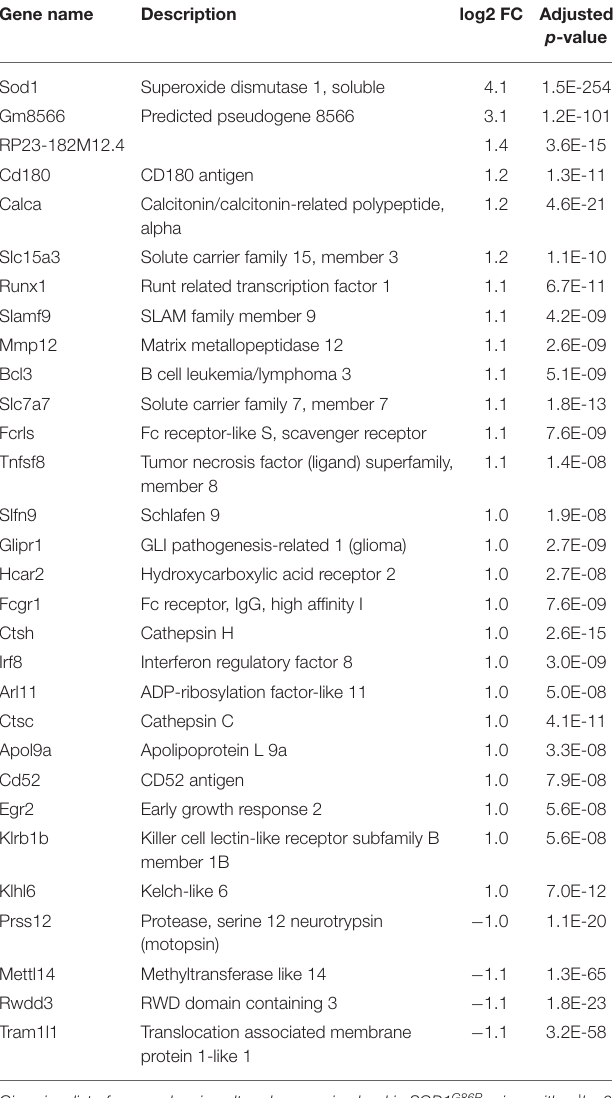
TABLE 1 | Transcriptomic dysregulation in the spinal cord of SOD1 G86R mice.